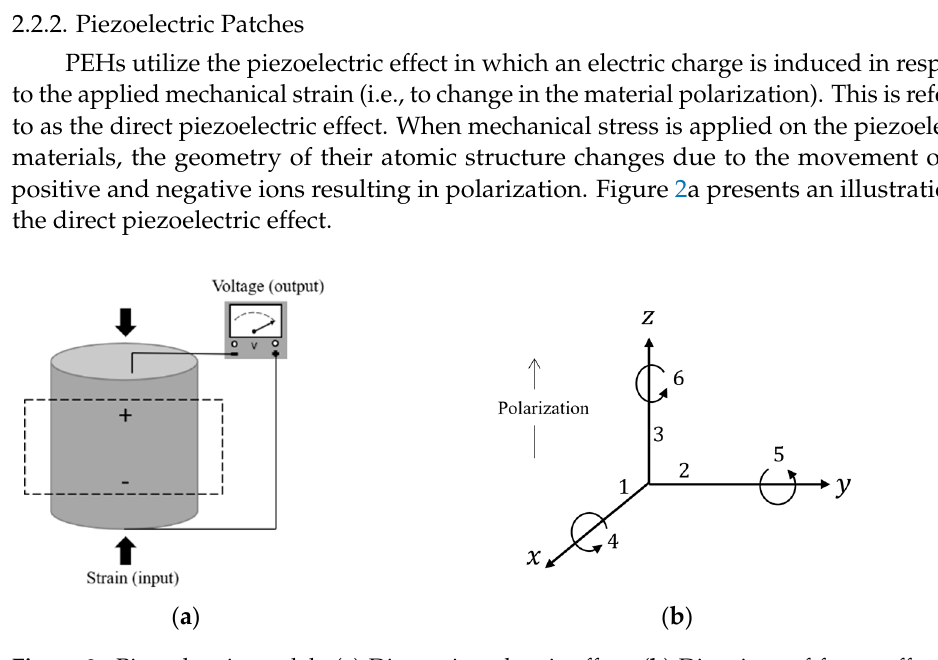
Figure 2. Piezoelectric model. ( a ) Direct piezoelectric effect; ( b ) Directions of forces affecting a piezoelectric element.